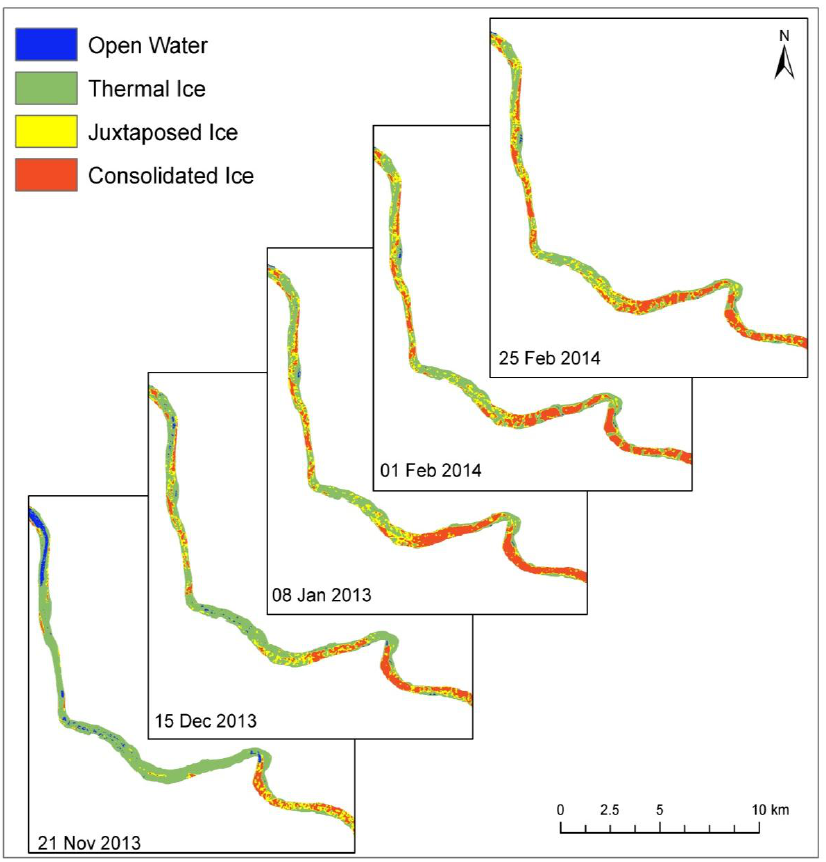
Figure 13. Freeze-up progression along the Slave River Delta channel from Jean River to Great Slave Lake.